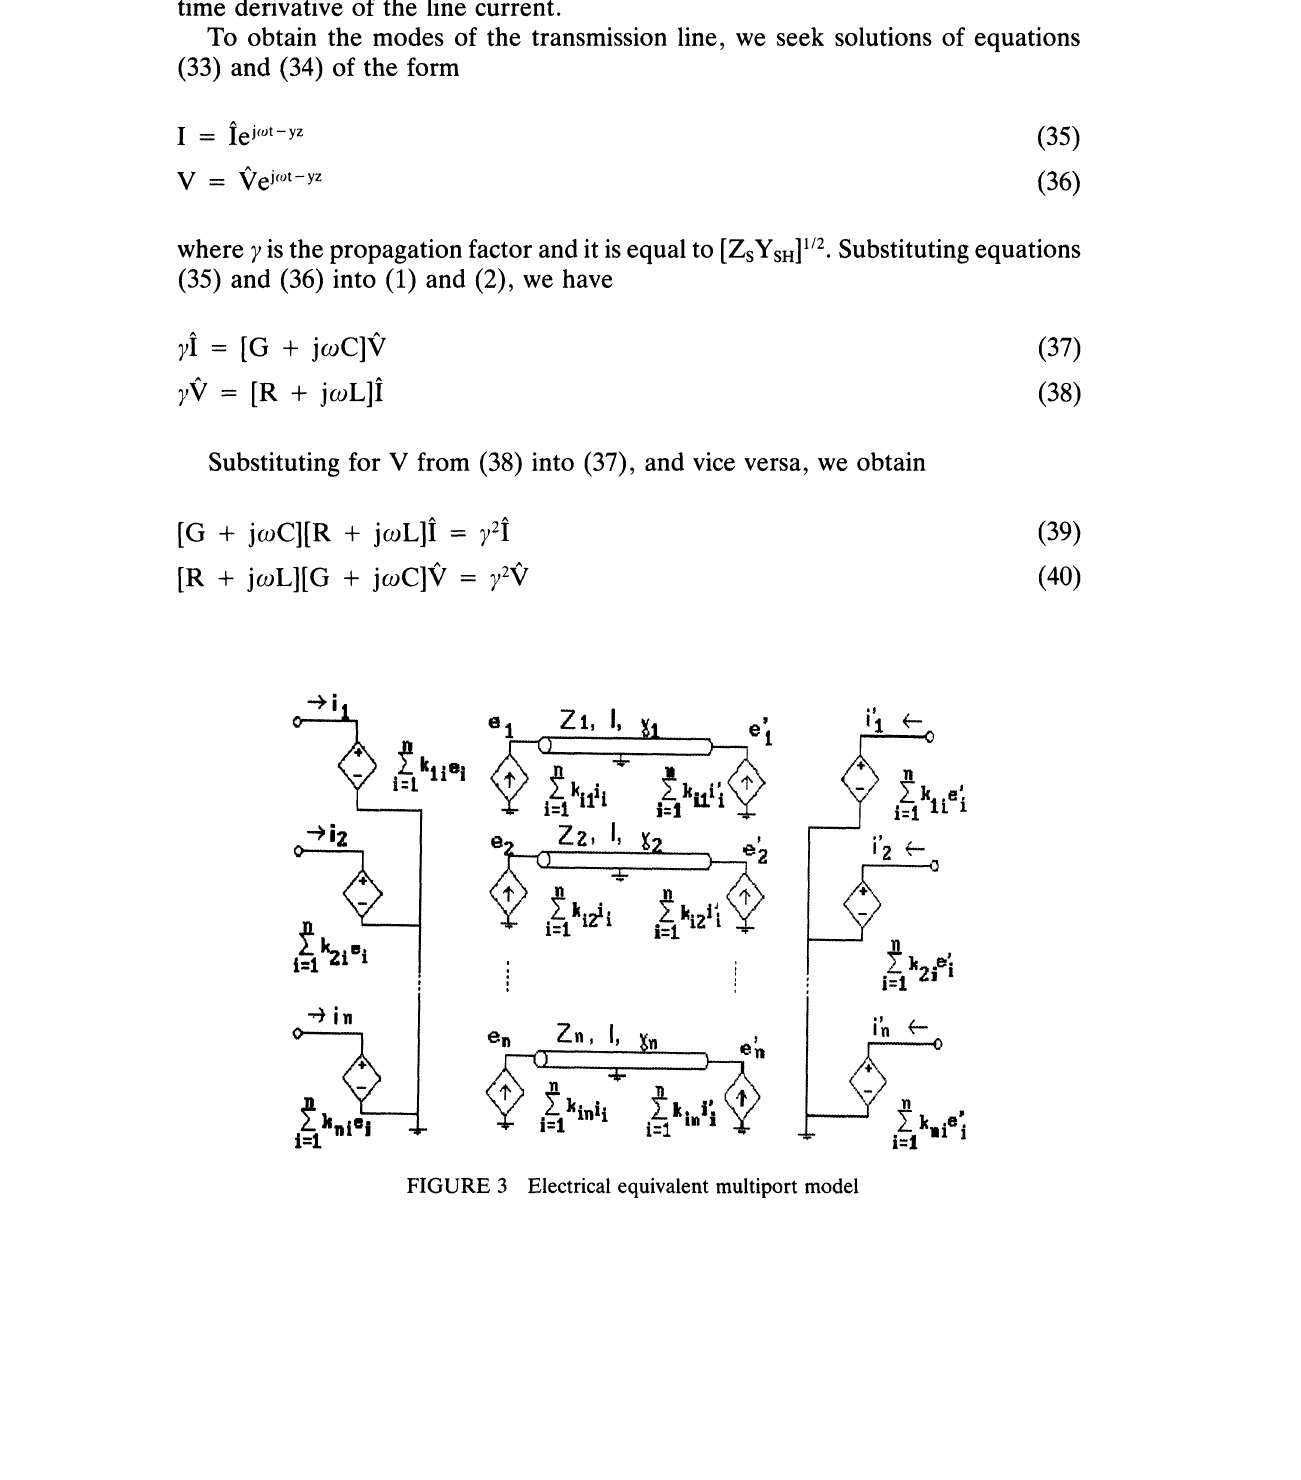
FIGURE 3 Electrical equivalent multiport